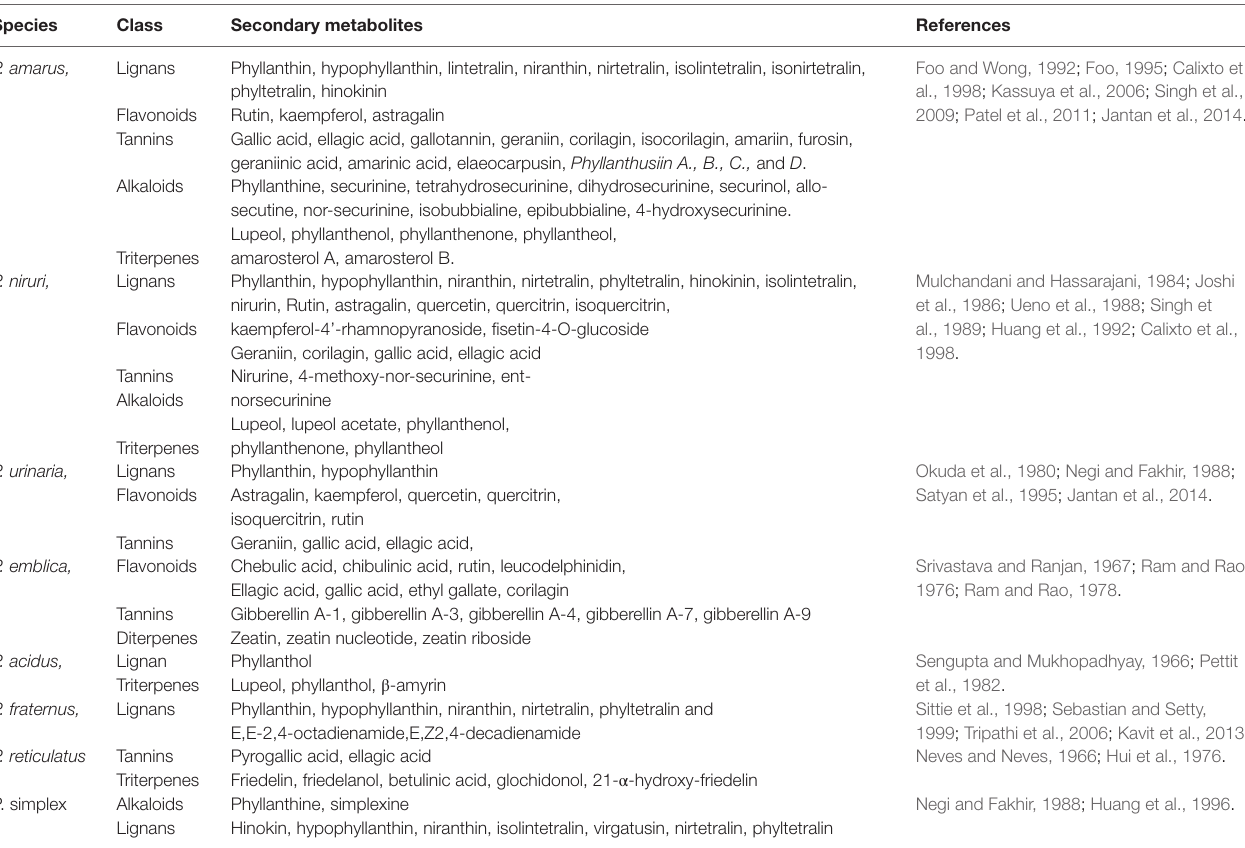
TABLE 1 | Phytochemicals isolated from Phyllanthus